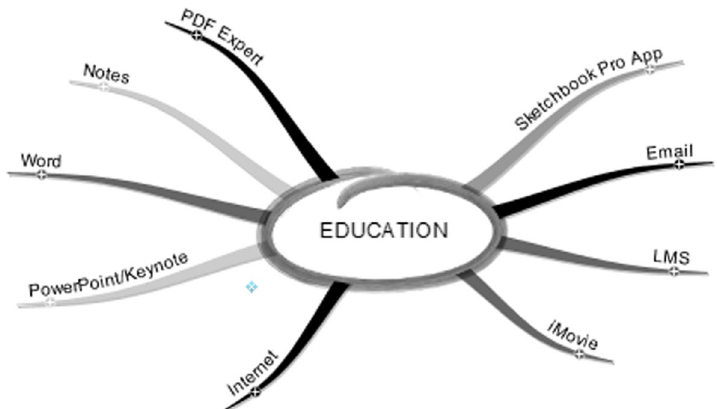
Fig. 2 The tools students use for educational